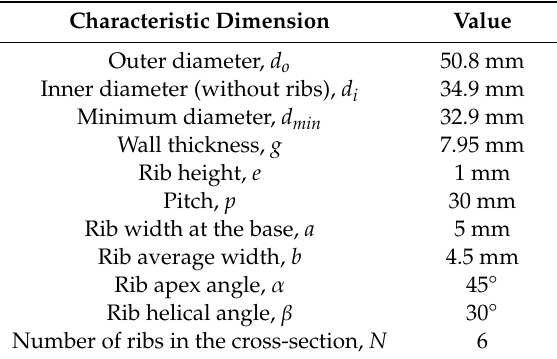
Table 2. Characteristic dimensions of the experimentally-tested tube with internal helical ribs [34].